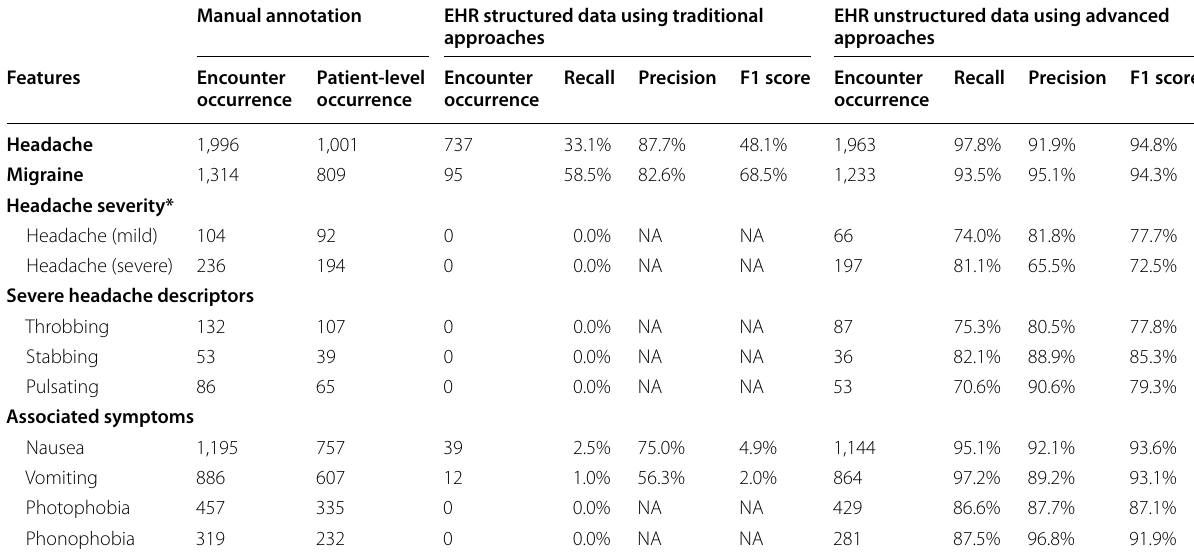
* Sample sizes for moderate headache, disabling headache, debilitating headache, and piercing headache were below requirements for inclusion (< 20 occurrences) EHR Electronic health record, NA Not